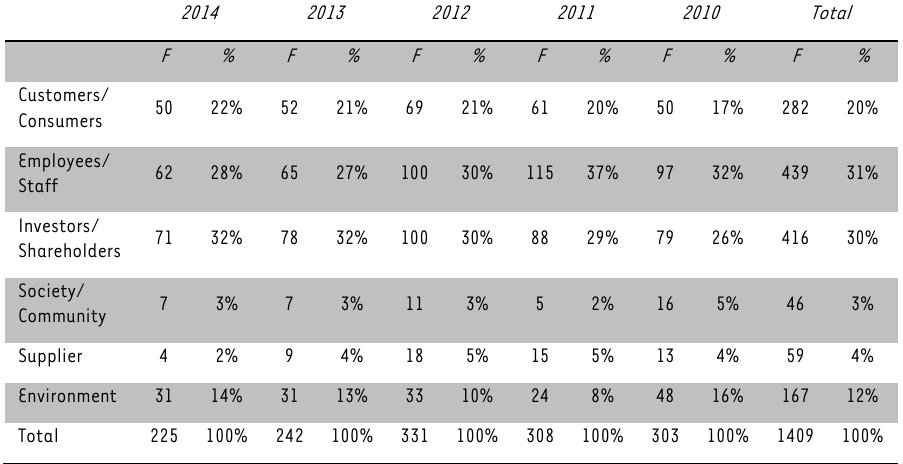
TABLE 15: Clicks stakeholder frequencies from 2010 to